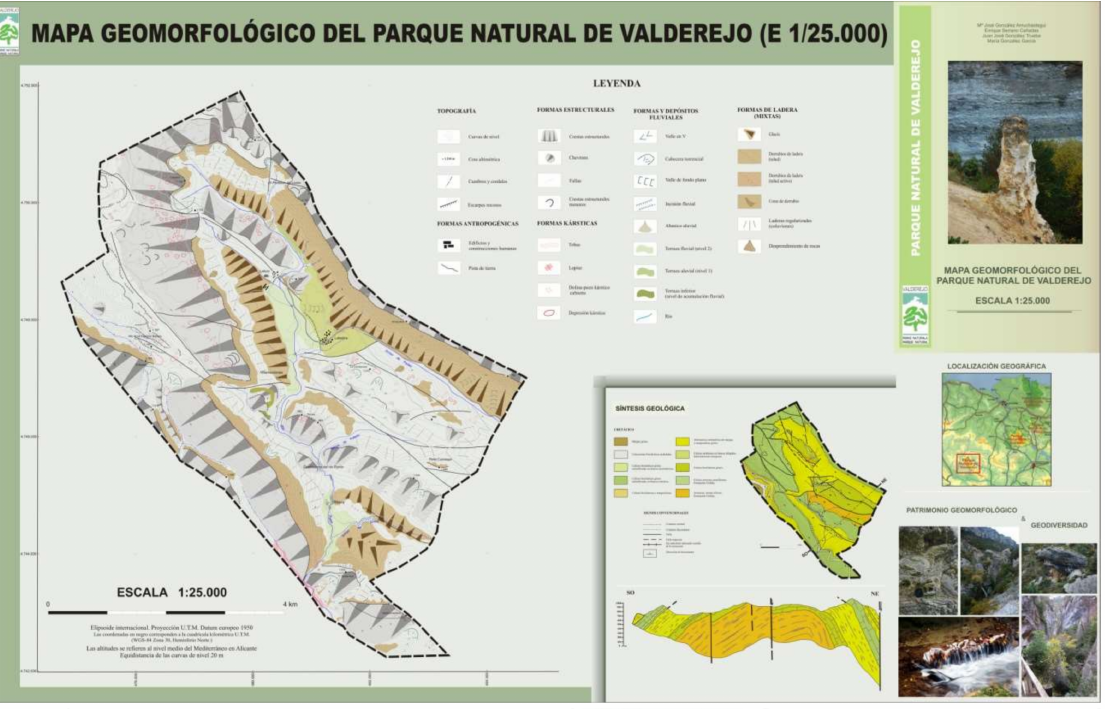
Figure 6. Edition of the geomorphological map to be published by the park